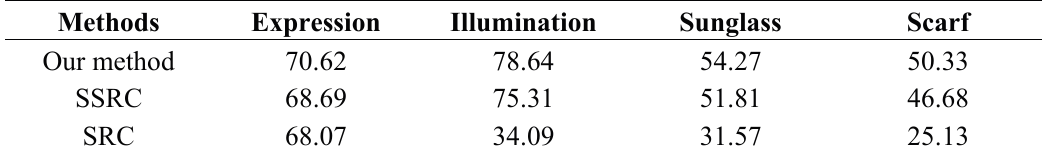
Table 3. Comparative recognition rates of SRC, SSRC and our method on the AR database using a single training sample per person.